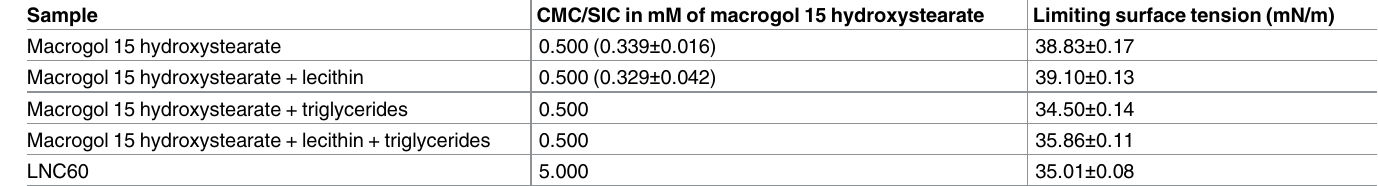
Table 3. Critical micellar concentration (CMC), saturated interfacial concentration (SIC) and the limiting surface tension of the MHS solution, LNC dispersion and binary and ternary mixtures of LNC components as determined by the Wilhelmy plate method. The CMC/SIC is the concentration at which a sharp changein the slope has occurred. The concentrations (given in brackets) correspond to the calculatedCMC/SIC based on the slope of the sur- face tension isotherms. The limiting surface tensionis the lowest surface tensionobserved for a given system regardless of the bulk